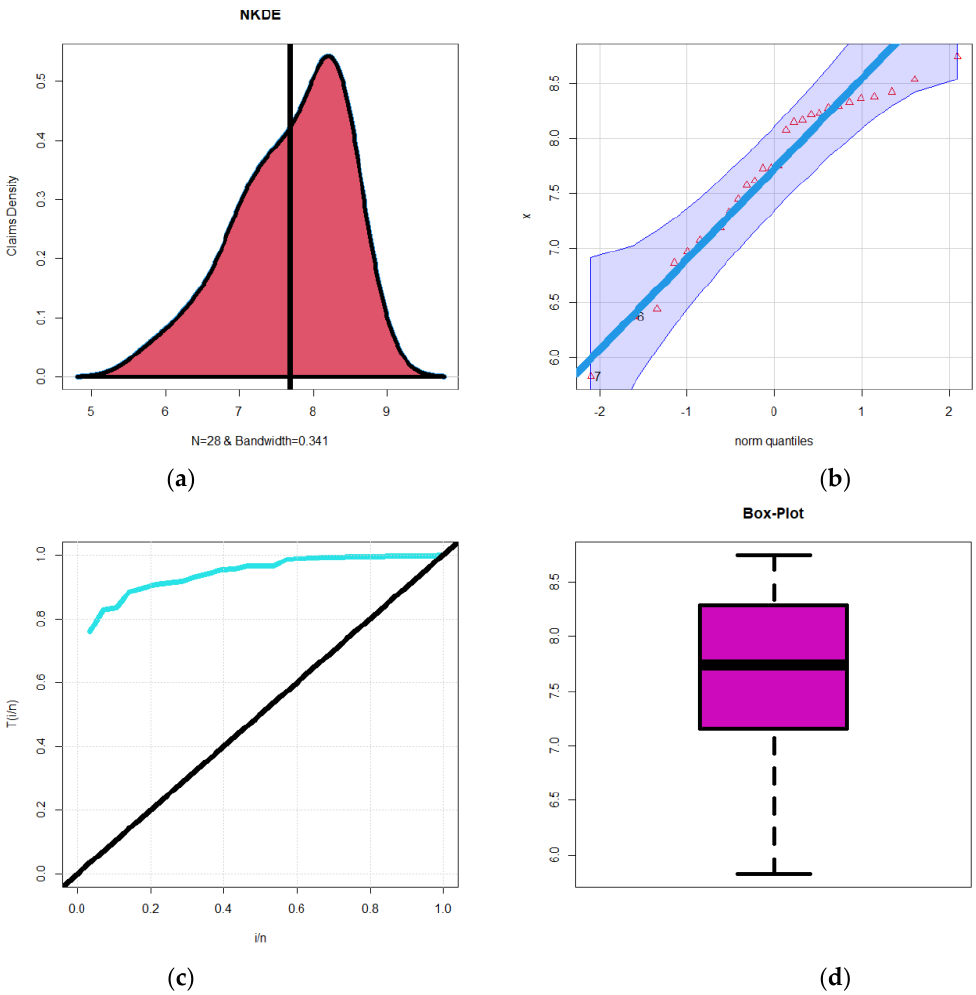
Figure 9. NKDE ( a ); Q – Q ( b ); TTT ( c ); box plots ( d ).